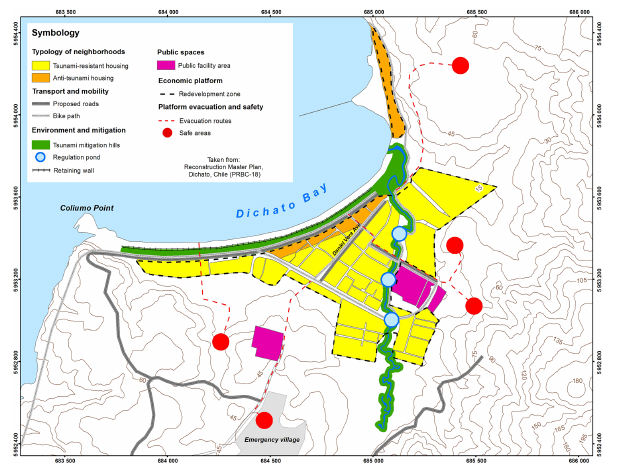
Figure 9. Pre- and post-tsunami vulnerability in